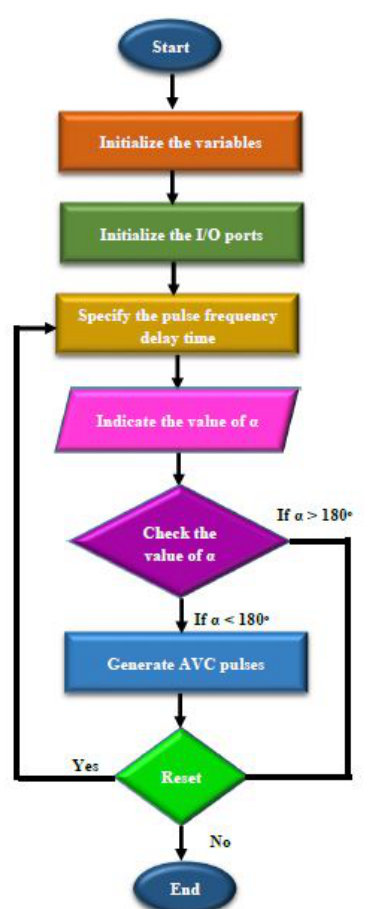
Figure 15. AVC pulse generation.